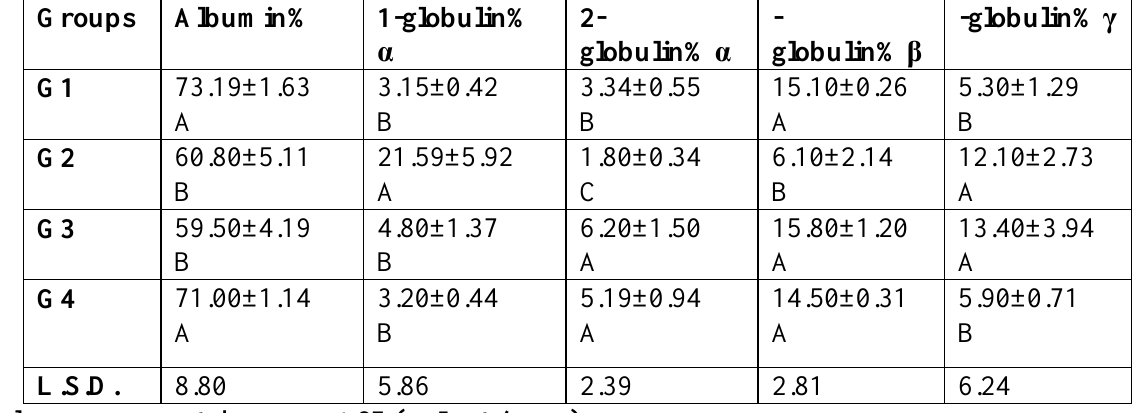
Table(3):- Agarose protein electrophoresis (protein fraction %) in serum of rats received 1% H2O2 in drinking water & intubated orally with 200mg/kg B.W. of polyphenolic compounds of olive